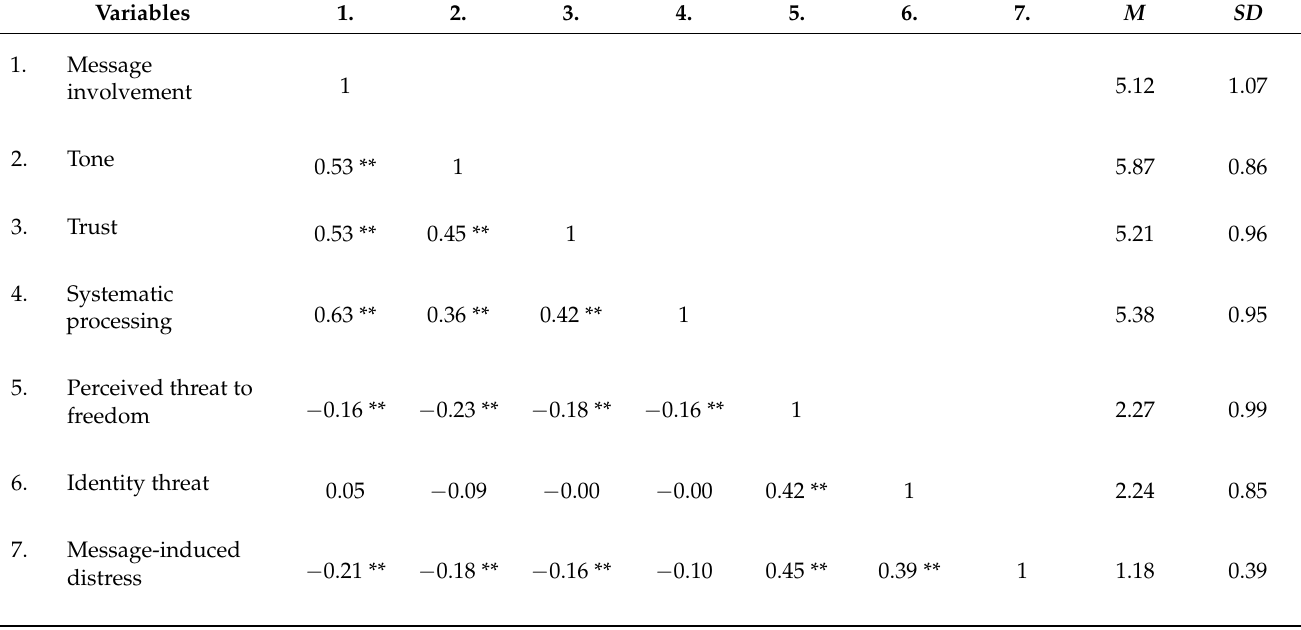
Table 3. Means, standard deviations, and correlations among the message evaluation